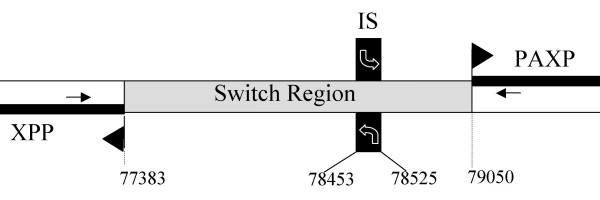
Schematic representation of the strand switch region (SSR) of chromosome 1 in L. major Friedlin. The nt positions (figures) refer to the complete sequence of this chromosome available on the GeneDB website [28]. XPP: acidocalcisomal exopolyphosphatase gene; PAXP: poly(A) export protein gene; IS: putative transcription initiation site, with the curved arrow showing transcription sense [14]. The start codons of both genes are indicated by a closed arrowhead. It is noteworthy that, after careful compared analysis with the genomes of Trypanosoma brucei and T. cruzi, we repositioned the start codon of PAXP at position 79049 and not at 79145 as wrongly indicated on GeneDB. The positions of the primers on the XPP and PAXP genes are indicated as arrows.